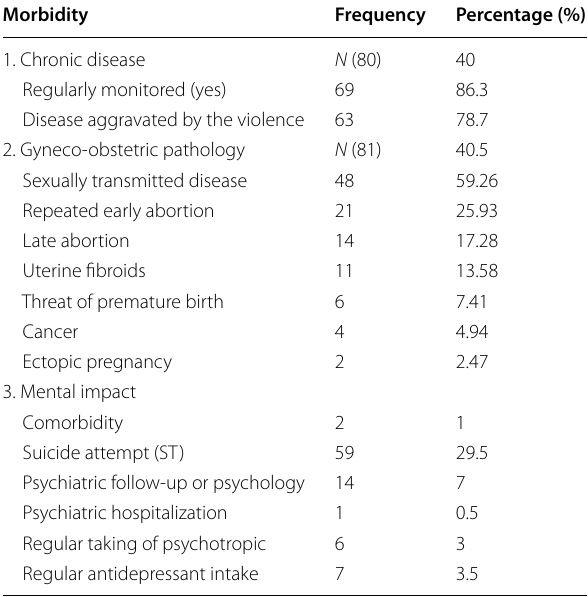
Table 3 Impact of domestic violence on the general and mental health of victims